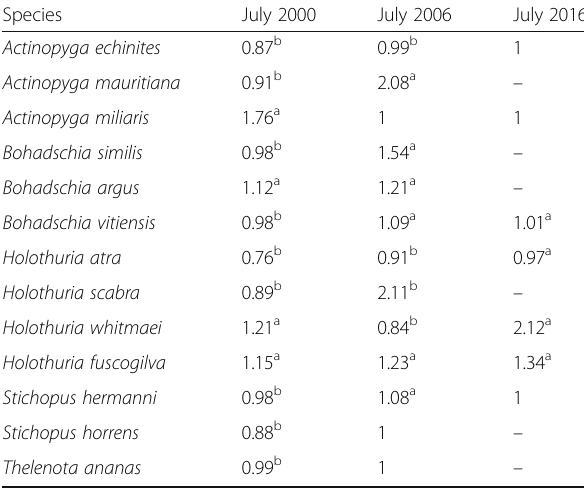
Table 6 The coefficient of dispersion (CD) of sea cucumber species recorded from the study site